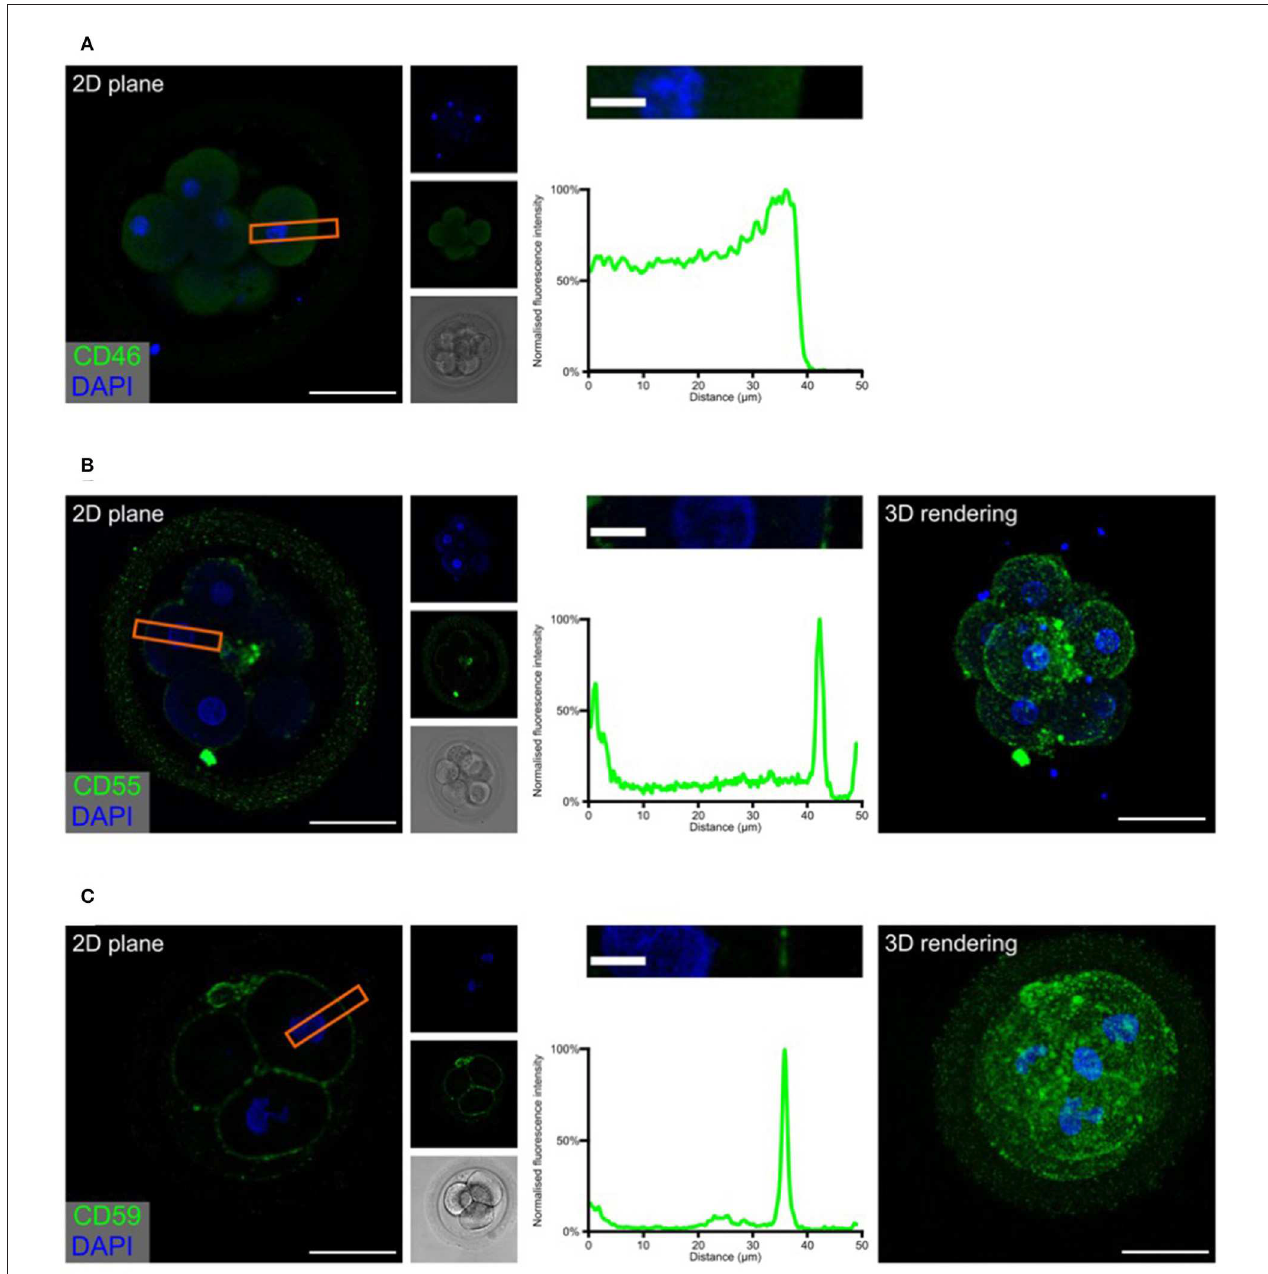
FIGURE 3 | Embryonic expression of surface-tethered complement inhibitors. Human cleavage stage IVF embryos were thawed in Vitrolife G-TL serum-free media. The embryos were incubated with anti-complement antibodies and analyzed by confocal microscopy. The analysis revealed a clear staining for both CD55 and CD59, particularly at cellular junctions. In contrast, no positive signal was observed for CD46. (A) CD46 (B) CD55 (C) CD59. Left panels: Single plane, overlay of protein stain (green) and DAPI (blue). Second column panels top to bottom: DAPI, protein, and BF. Third column panels: Magnification of overlay (orange insert), and below the cross-sectional distribution of fluorescence intensity. Right panels (B,C) : 3D rendering, overlay of protein stain and DAPI. Scale bars: 50 µ m, insert: 10 µ m. For each staining, n = 3 + 7 (2PN + 3PN